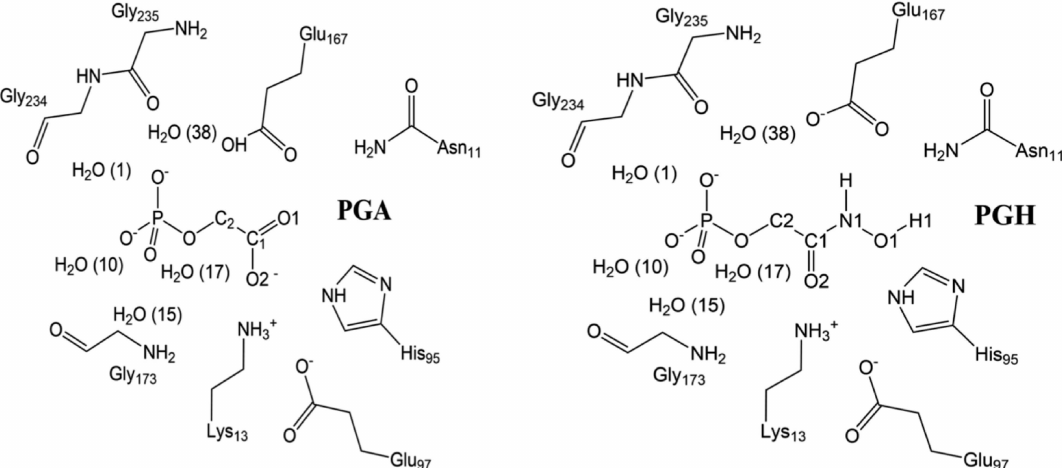
Figure 2 Scheme of the active site of TIM with the inhibitors PGA (left) and PGH (right), also showing the atom numbering of the inhibitor and the waters. The atoms shown were used as the quantum system for the QM/MM calculations. The overall charge of PGA and PGH is (cid:5) 3 and (cid:5) 2,